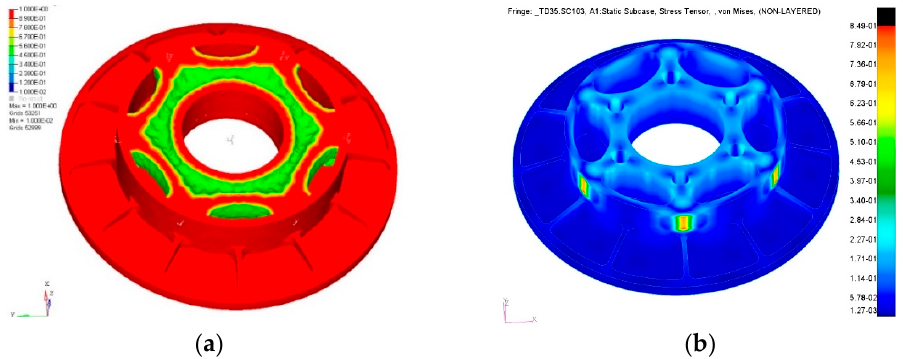
Figure 9. ( a ) Topological optimization result. ( b ) Stress contour plot. Stress contour plot of the mirror subjected to TCML.